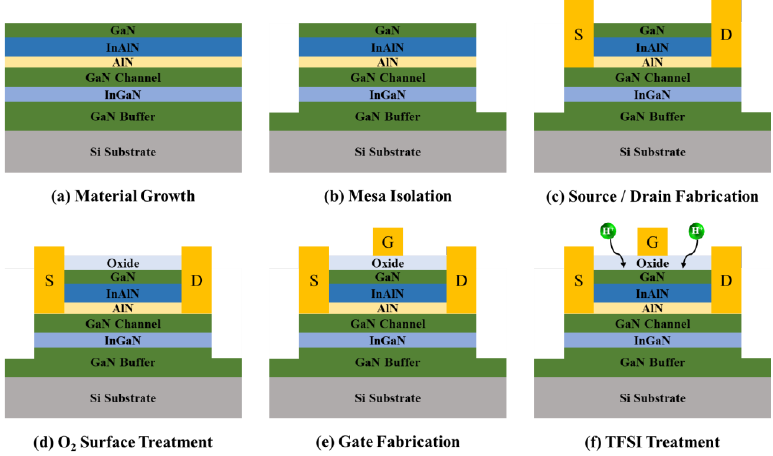
Figure 1. Schematic of the fabrication process for InAlN/GaN HEMT on Si substrate: ( a ) material growth, ( b ) mesa Isolation, ( c ) source/drain fabrication, ( d ) O 2 surface treatment, ( e ) gate fabrication, ( f ) TFSI surface treatment.